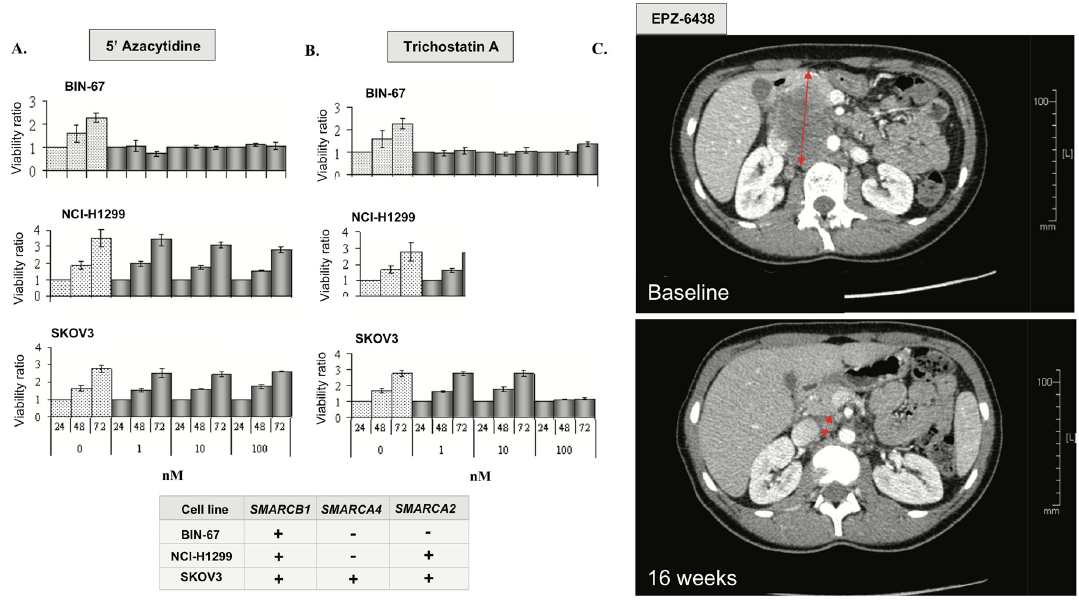
Figure 5. Epigenetic vulnerabilities in SCCOHT A, B. Anti-proliferative effects of 5 ′ -AZAC ( A ) and TSA ( B ); − designates protein loss or loss-of-function mutation and / or loss of expression; + designates absence of mutation (wild-type status) and retained expression. ( C ) Rapid clinical response in SMARCA4 -mutated SCCOHT treated with the EZH2 inhibitor EPZ-6438. A CT scan of the tumor at baseline and after four months of EPZ-6438 treatment with 70% decrease in tumor volume (RECIST